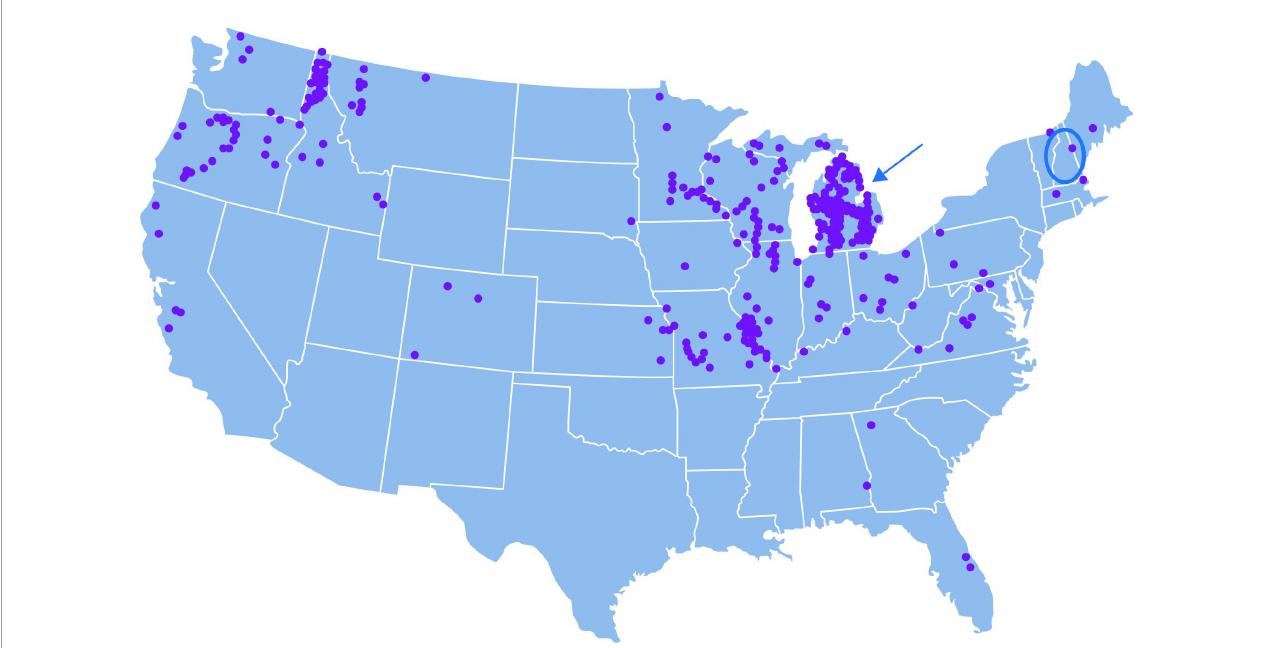
FIGURE3 Map of USA in which each dot represents one call to a U.S. poison center regarding ingestion of a mushroom species containing monomethylhydrazine (MMH) over the 10-year period 2001–2011. Redrawn from Hatten et al. (2012). A 2006 paper from the North American Mycological Association tabulated reports of acute illness from Gyromitra spp. (including G. brunnea, esculenta, gigas, montana ) from Arkansas, Idaho, Iowa, Massachusetts, Michigan, Montana, Quebec, Oregon, and Washington (Beug et al., 2006), and an Asian couple west of the North American Rockies (Leathem and Dorran, 2007). Several MMH reports originated from the northwestern United States (notably Oregon, Idaho), northcentral and central states, including Wisconsin (adjacent to Michigan) Missouri (southernmost cluster of dots) and a few from New England states, including New Hampshire ( oval ). (Upper-right) The highest concentration of MMH-related calls came from Michigan ( arrow ) in the Great Lakes region of the upper Midwestern United States, the home of several species of poisonous False Morels (Mushroom Observer, 2015). Areas of Michigan suspected to have a high ALS incidence include the towns of Cadillac and Greenville, and Newaygo County (Anon, 2022b). Mesick, a town 19 miles northwest of Cadillac, holds morel-hunting contests at the May Annual Mesick Mushroom Festival (Anon, 2022p). The National Morel Mushroom Festival takes place in Boyne City in northern Michigan (National Morel Mushroom Festival, 2022). These locations are all in northern Michigan’s Lower Peninsula where wild morels have been mapped (Morels, 2022). Note that fungi take up not only metals from soil but also persistent environmental pollutants, including organochlorine pesticides, polychlorinated biphenyls, and brominated flame retardants (Moeder et al., 2005; Rodríguez-Rodríguez et al., 2012; Bokade et al., 2021), certain members of which were elevated in the blood of Michigan patients with ALS (Su et al.,